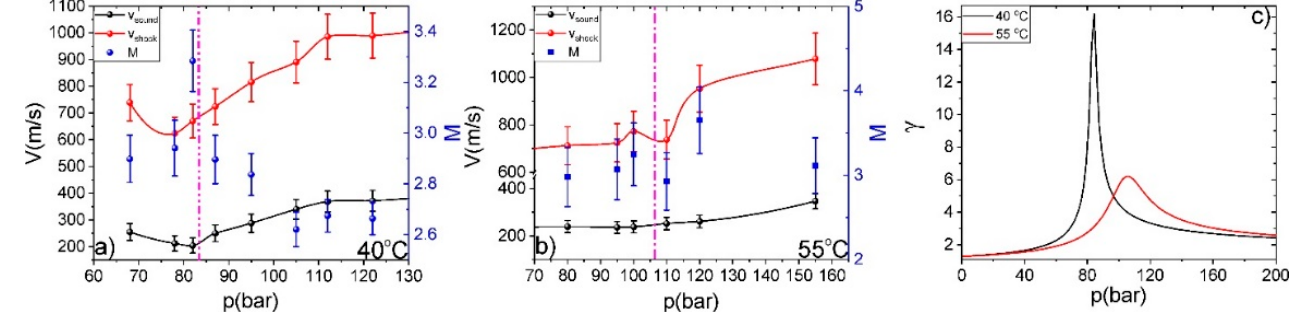
Figure 3. ( a , b ) Dependence of the sound velocity (black line), shock wave velocity (red line) and the Mach number—the ratio of flow velocity to the local speed of sound (blue dots) on the pressure inside the cell for different temperatures. Dash–dot line indicates the Widom line (the minimum sound speed). ( c ) Dependence of the adiabatic index on pressure for different temperatures based on the data from [33]. The maxima in ( c ) correspond to the Widom